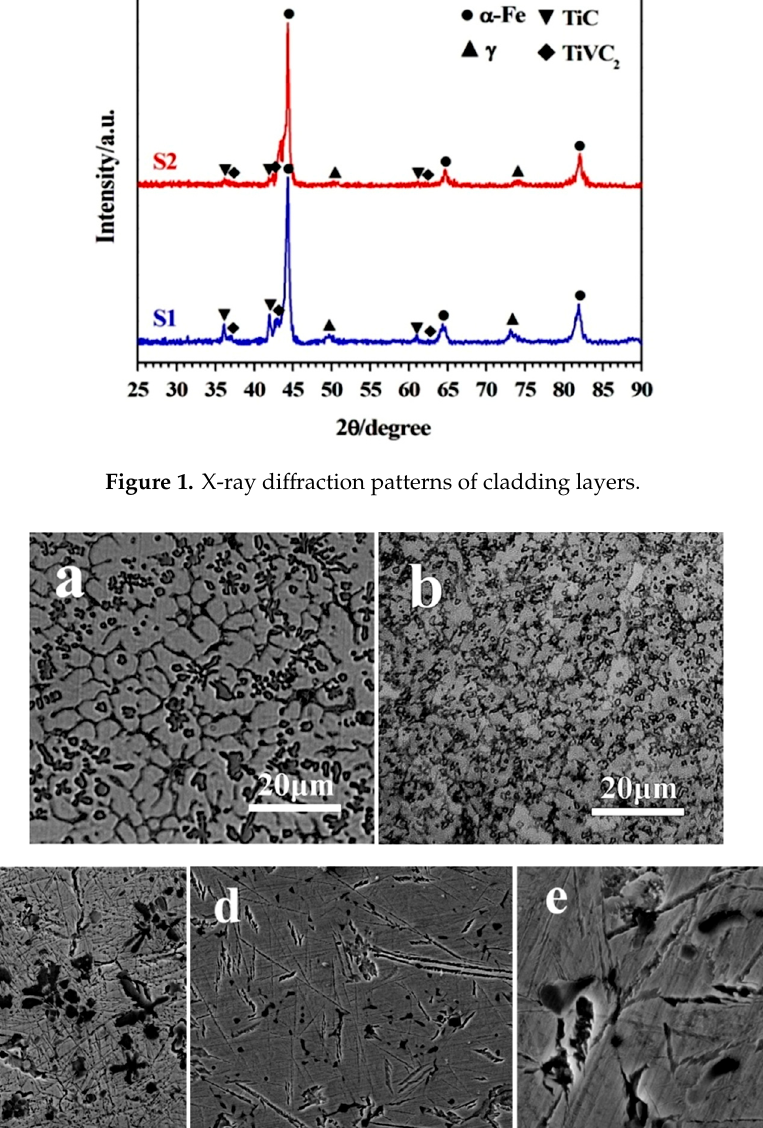
Figure 2. Optical morphologies ( a ) S1 ( b ) S2 cladding layer and secondary electron micrographs ( c ) S1 ( d , e ) S2 cladding layer.